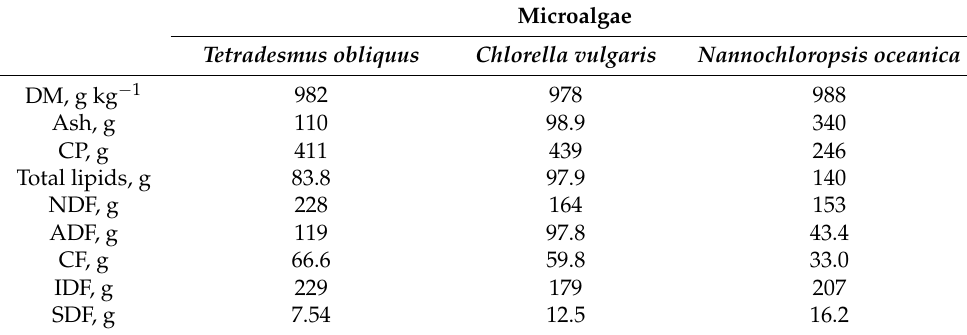
Table 1. Proximate composition of the spray-dried microalgae species studied (unit per kg of dry matter, DM) 1